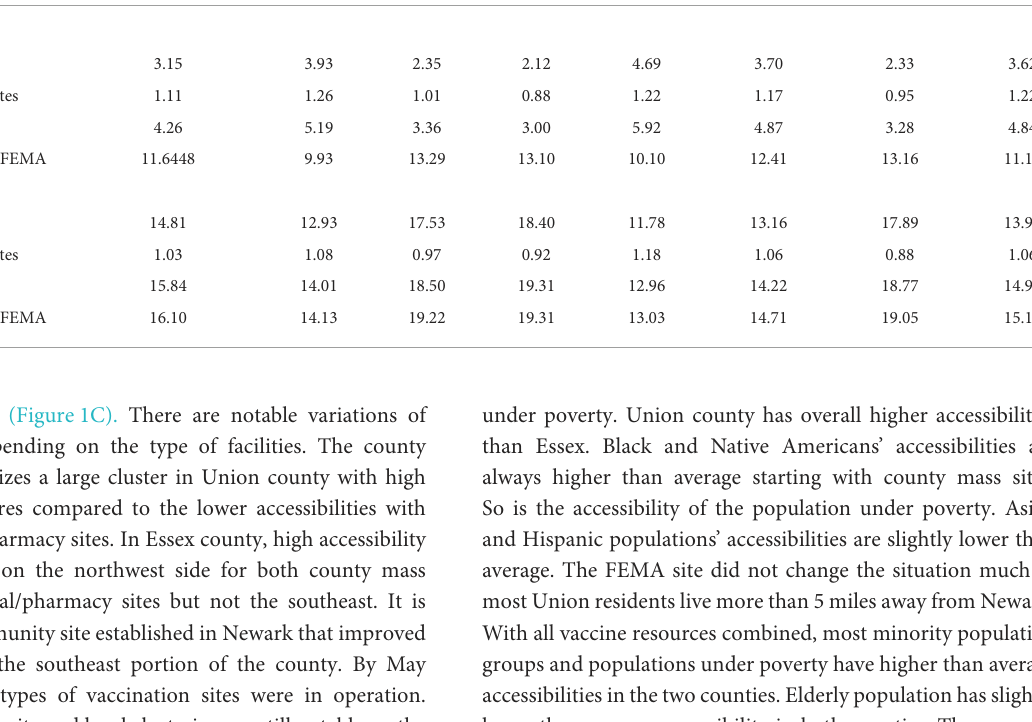
TABLE 1 Average accessibilities of different population groups. All population White Black Native Asian Hispanic Poverty